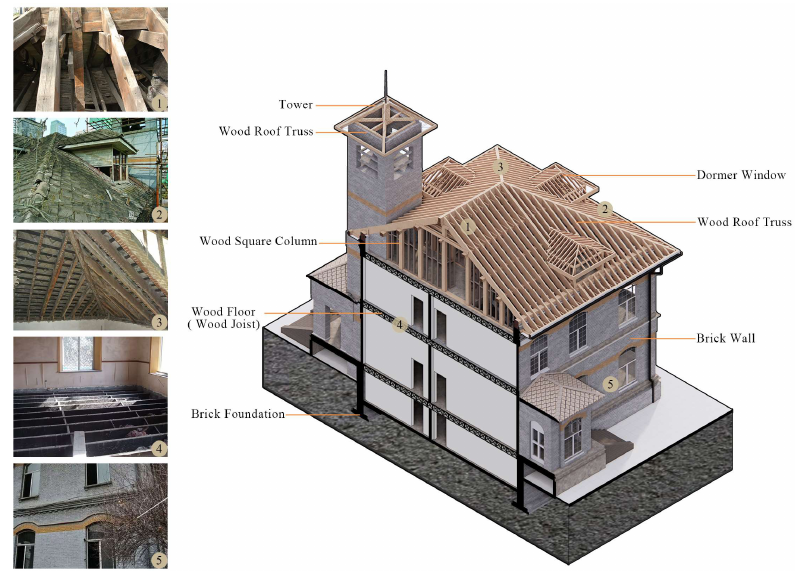
Figure 6. Current photos of the bell tower (source: author). ( a ) Bird’s-eye view of the bell tower